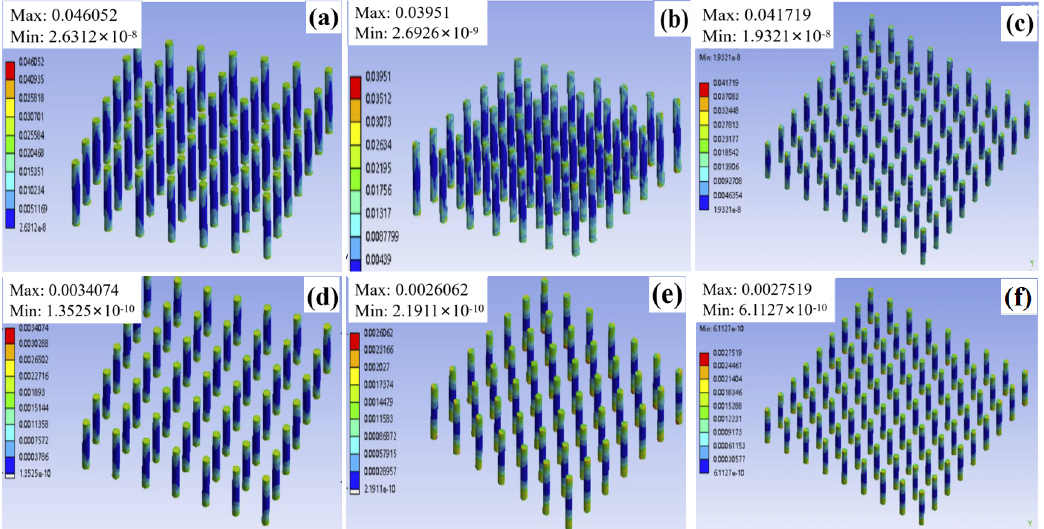
Figure 9. FEM analysis of stress ( a – c ) and strain ( d – f ) analysis of CCGA575 electronic packaging sub ‐ jected to TC: 9 × 9, SAC105: ( a , d ); 9 × 9, SAC105 ‐ (nano)Al 2 O 3 /Cu: ( b , e ); 11 × 11, SAC105 ‐ (nano)Al 2 O 3 /Cu: ( c , f ).